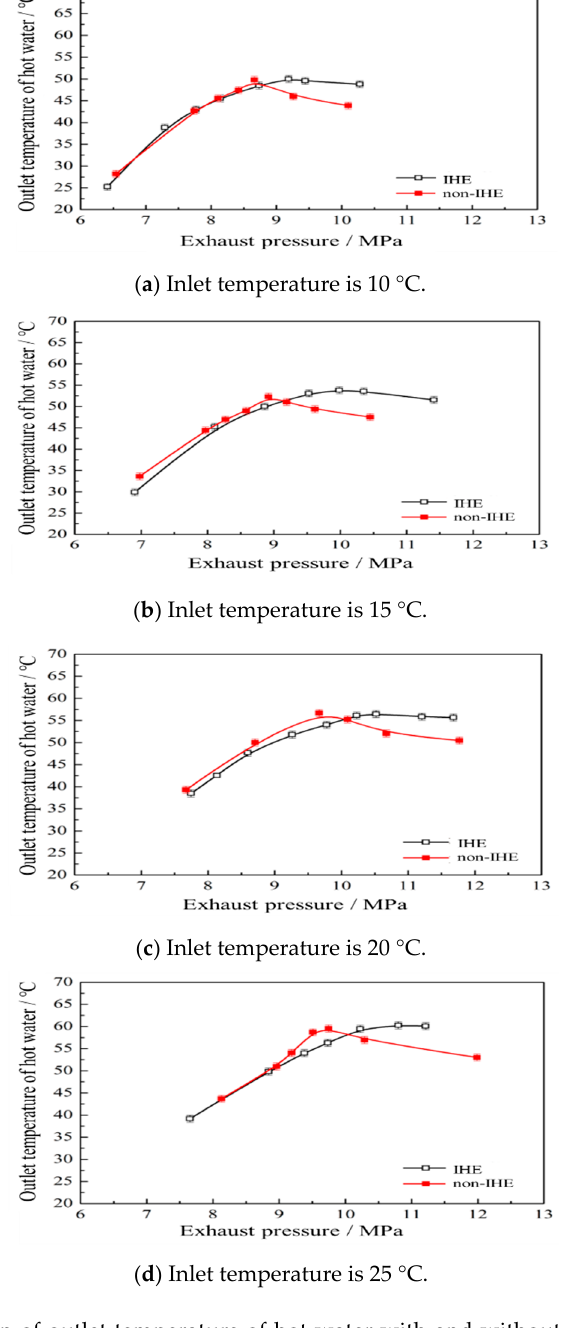
Figure 8. Comparison of outlet temperature of hot water with and without IHX at different inlet temperatures of water source.